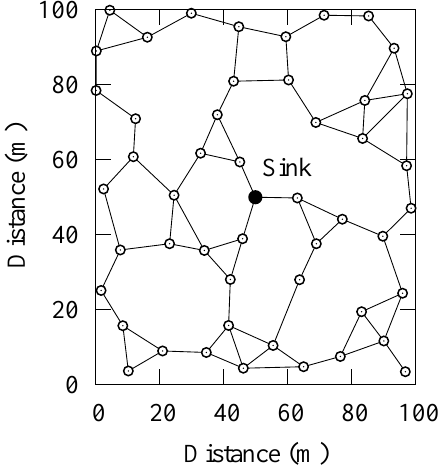
Figure 7. Simulation topology. A link is drawn between nodes within communication